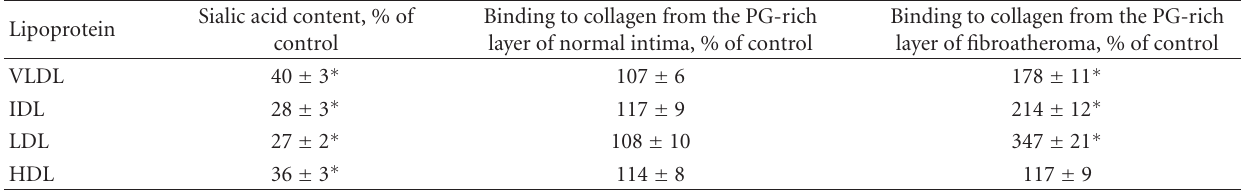
Table 5: E ff ect of neuraminidase treatment on lipoprotein sialic acid content and lipoprotein binding to collagen.